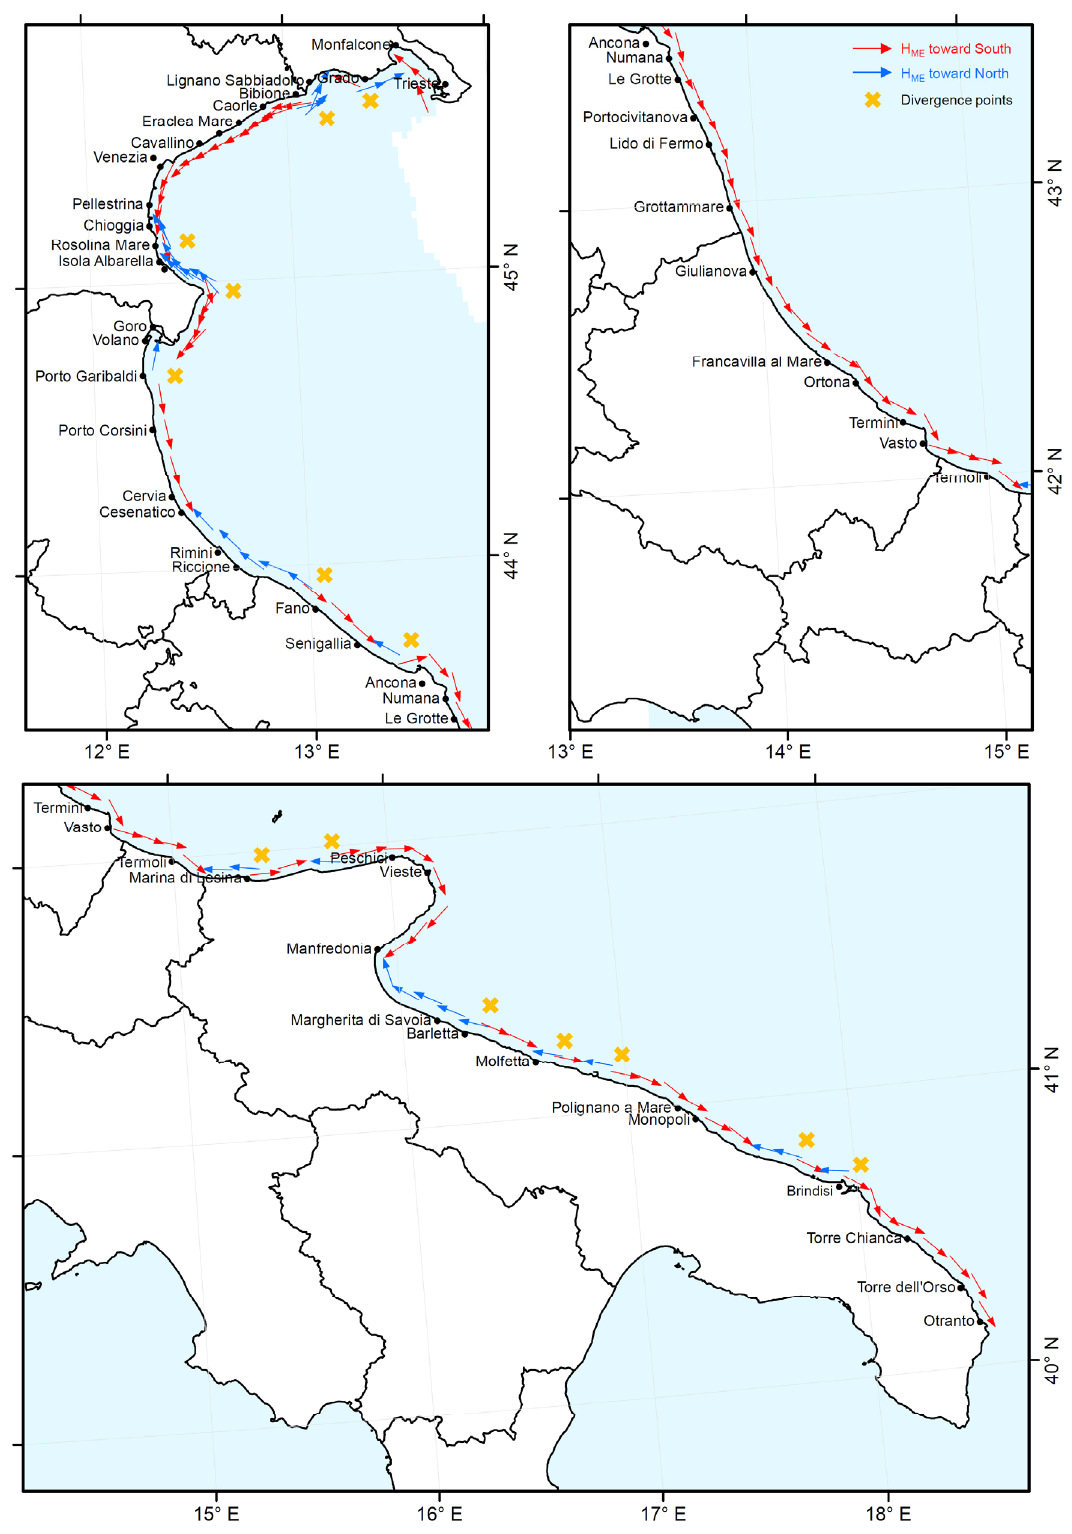
Figure 9. Direction of the morphological wave heights H ME along the Italian Adriatic coast. The H ME value is evaluated taking into account all waves with Hs > 0.5 m for the historic